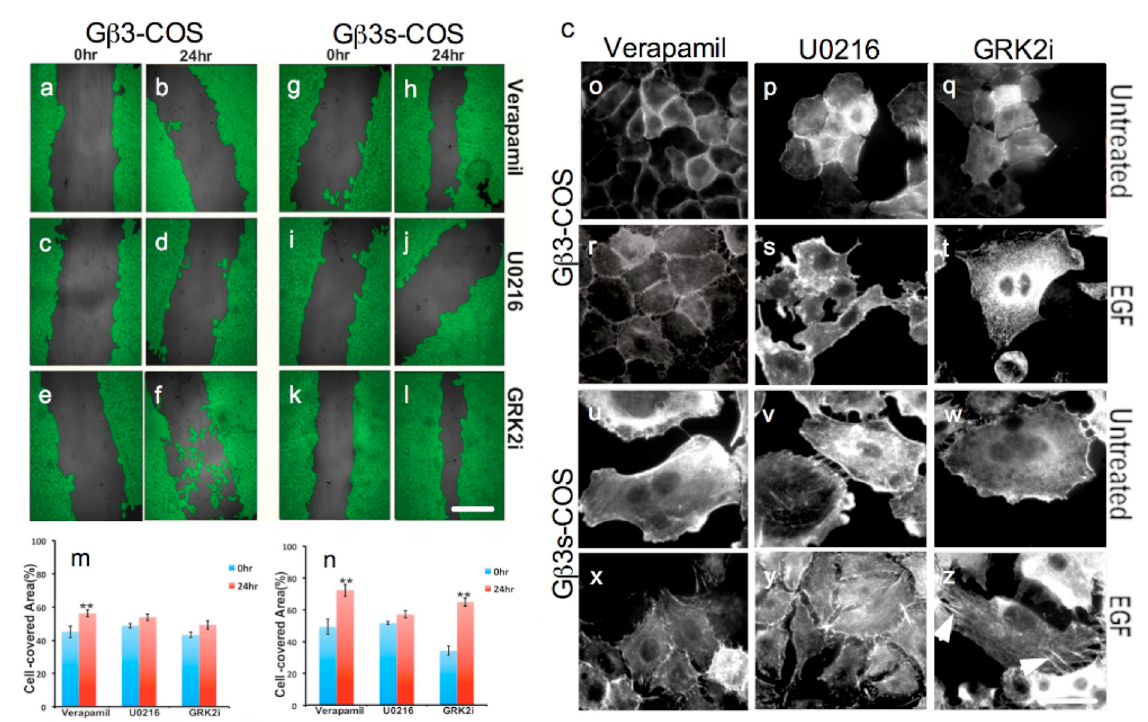
Figure 13. Disruption of Actin stress fiber formation inhibits cell migration. The degree of wound gap closure was studied in G b 3-COS and G b 3s-COS cells by scratch wound assay (c-l) for which, scratches were made with a fine tip on coverslips containing stable clonal adherent G b 3 and G b 3s-COS cell lines. Scratch wound healing assay revealed greater decrease in gap closure following verapamil (g & h) and U0216 (i & j) treatment while to a lesser extent, following GRK2i treatment (k & l) in G b 3s-COS cell line. Gap closure in G b 3-COS cell was sensitive to all inhibitor treatments (a-f). This indicated the involvement of Ca +2 ions and ERK pathway in the enhanced scratch wound healing kinetics of G b 3s-COS cell line. Images are taken from different fields of view under a 5x objective with further 1.5x magnification. Bar = 100 m m. Graphical representation of the cell covered area as analyzed by WIMASIS tool as mentioned in materials and methods section (m-n). Data presented in all panels are the mean with standard error (bars) of n = 3 independent experiments. Statistical significance is shown as *P<0.05, **P<0.01, ***P<0.001. Actin stress fiber formation was inhibited following G bg signaling inhibition indicating the involvement of stress fiber formation for enhanced cell migration of G b 3s cells. While inhibitor treatments caused total disruption of EGF induced stress fibers in G b 3-COS cells (o-t), G b 3s-COS cells still retained some actin stress fibers following GRK2i treatment (indicated arrow heads) (z) indicating only partial inhibition of migration. The images are taken from different fields of view under 40x objective with further 1.5x magnification. Bar = 13 m